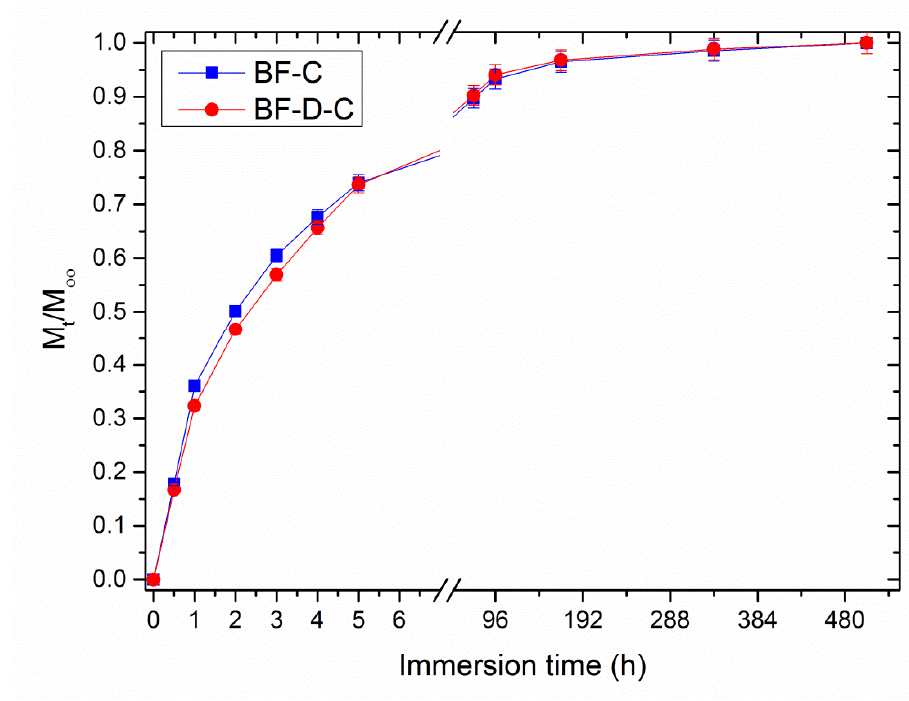
Figure 5. M t / M ∞ as a function of immersion time for BF-C and BF-D-C Figure 5. M t /M ∞ as a function of immersion time for BF ‐ C and BF ‐ D ‐ C samples.